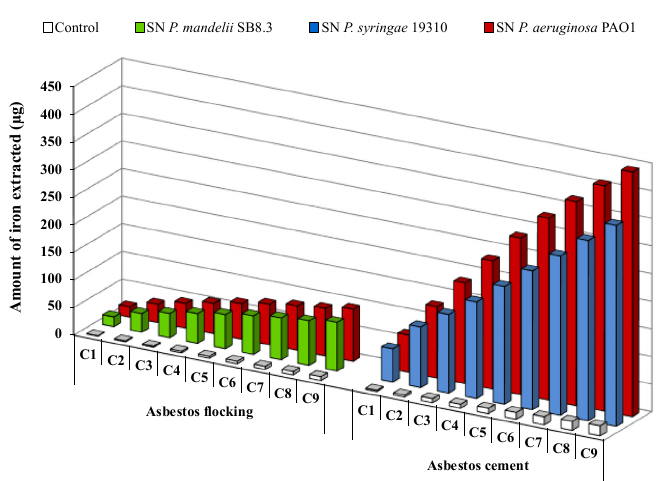
Figure 7. Iron removal from asbestos flocking or asbestos cement after 24 h renewal cycles (C1 to C9) in the presence of 100 µ M of Pseudomonas mandelii , Pseudomonas aeruginosa or Pseudomonas syringae pyoverdine-containing supernatants (SN). Adapted from David et al. [72,80].